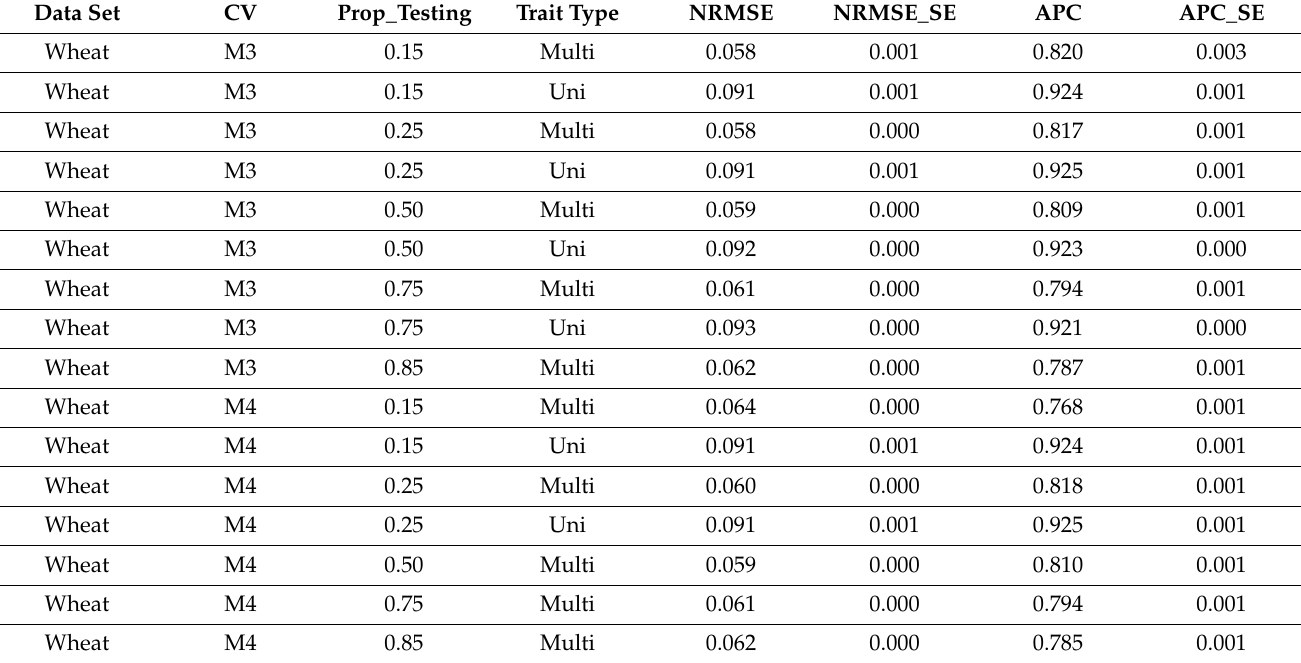
Table A2. Prediction performance for the complete wheat data in terms of normalized root mean square error (NRMSE) and Average Pearson’s correlation (APC) of the four sparse testing methods (CV) under the following proportion of testing (Prop_testing): 15% (0.15), 25% (0.25), 50% (0.5), 75% (0.75) and 85% (0.85). NRMSE_SE denotes the standard error of NRMSE, and APC_SE denotes the standard error of APC.